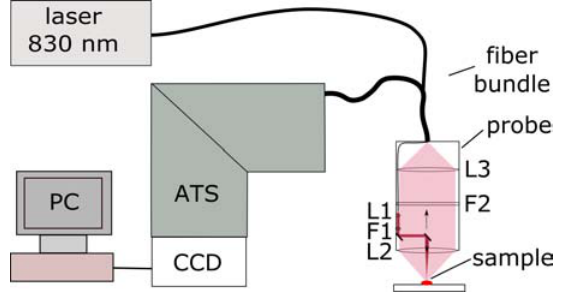
Fig. 4. Raman spectroscopy laboratory setup. L1 – L3 — len- ses, F1 — laser line ¯lter, F2 — longpass ¯lter, ATS — axial transmissive spectrograph.